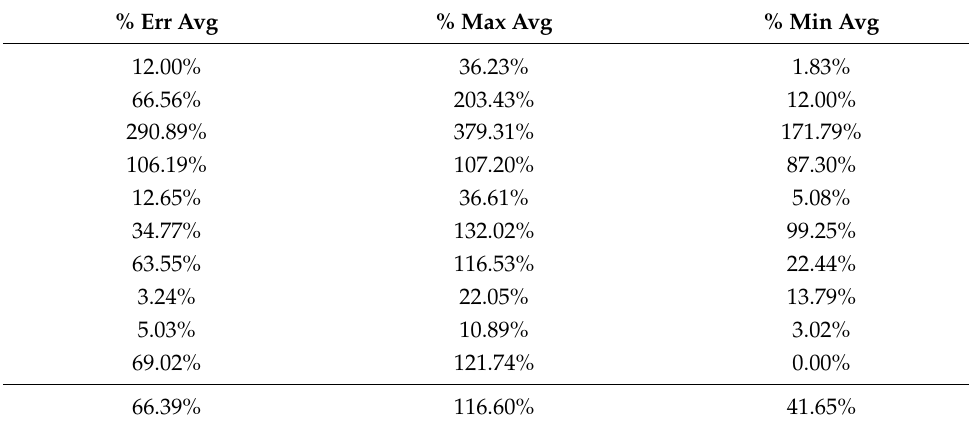
Table A89. Set 2, trials 1–10 data (all 0.5 PR values).